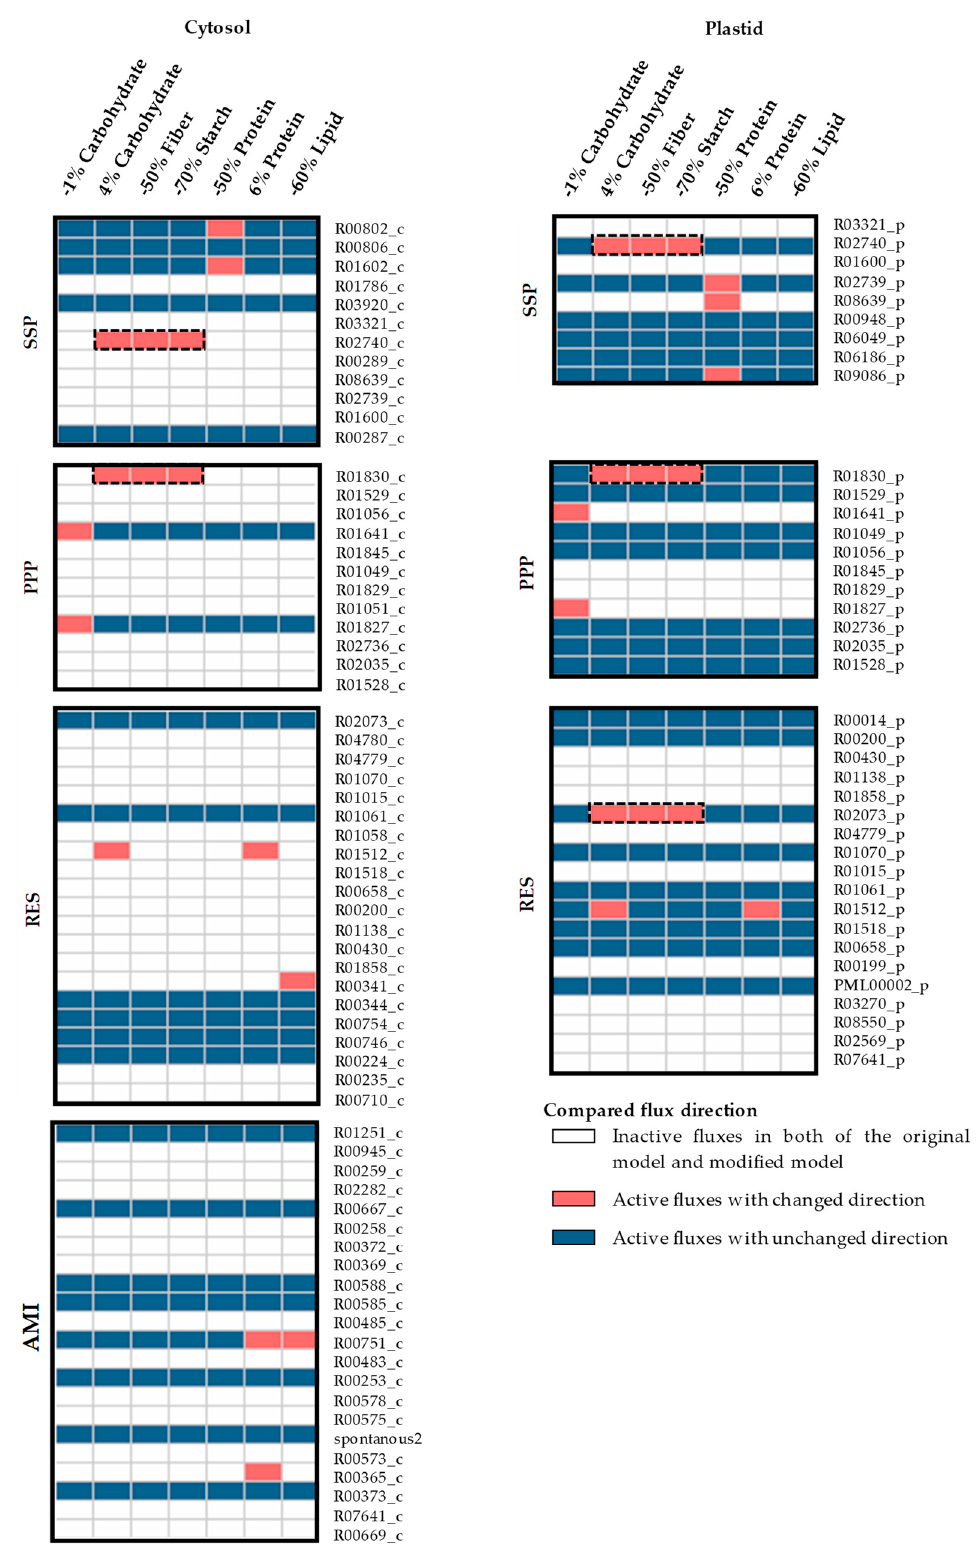
Figure 5. The influence of biomass compositions on the predicted flux direction of the rMeCBM-KU50 model. The reactions with zero flux predictions, inactive reactions, are denoted by white-colored bars. The non-zero flux reactions, active reactions, consists of those with similar flux direction as the original model—denoted by blue bars, and those that are dissimilar—denoted by red bars. AMI, amino acid biosynthesis pathway; PPP, pentose phosphate pathway; RES, respiration pathway; SSP, starch and sucrose biosynthesis pathway.